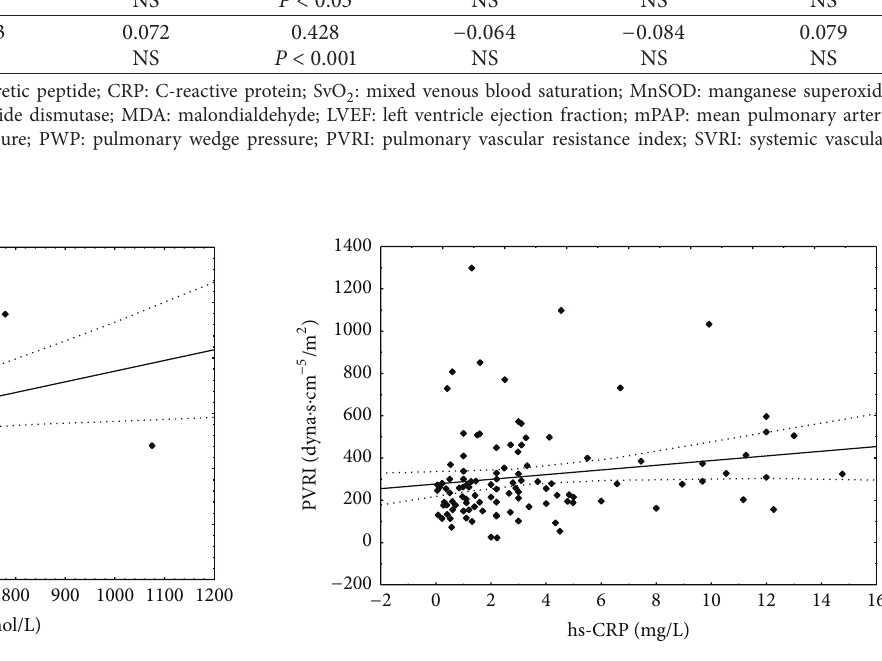
correlated with LVEF (Table 5).